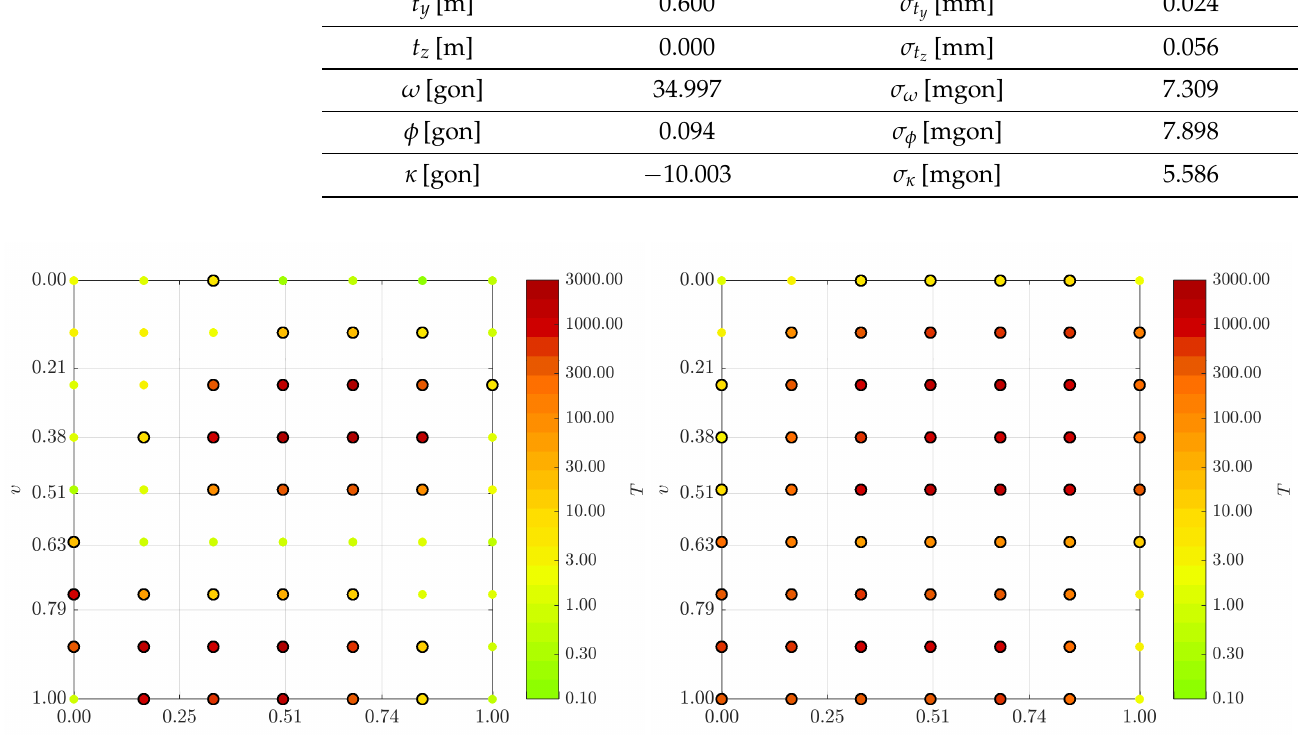
Figure A1. Test values T of the localisation procedure for data set V40. For the circled points, the null hypothesis has to be rejected and, thus, these points are assumed to lie in the distorted region. Left: a = 0, right: a = 1.